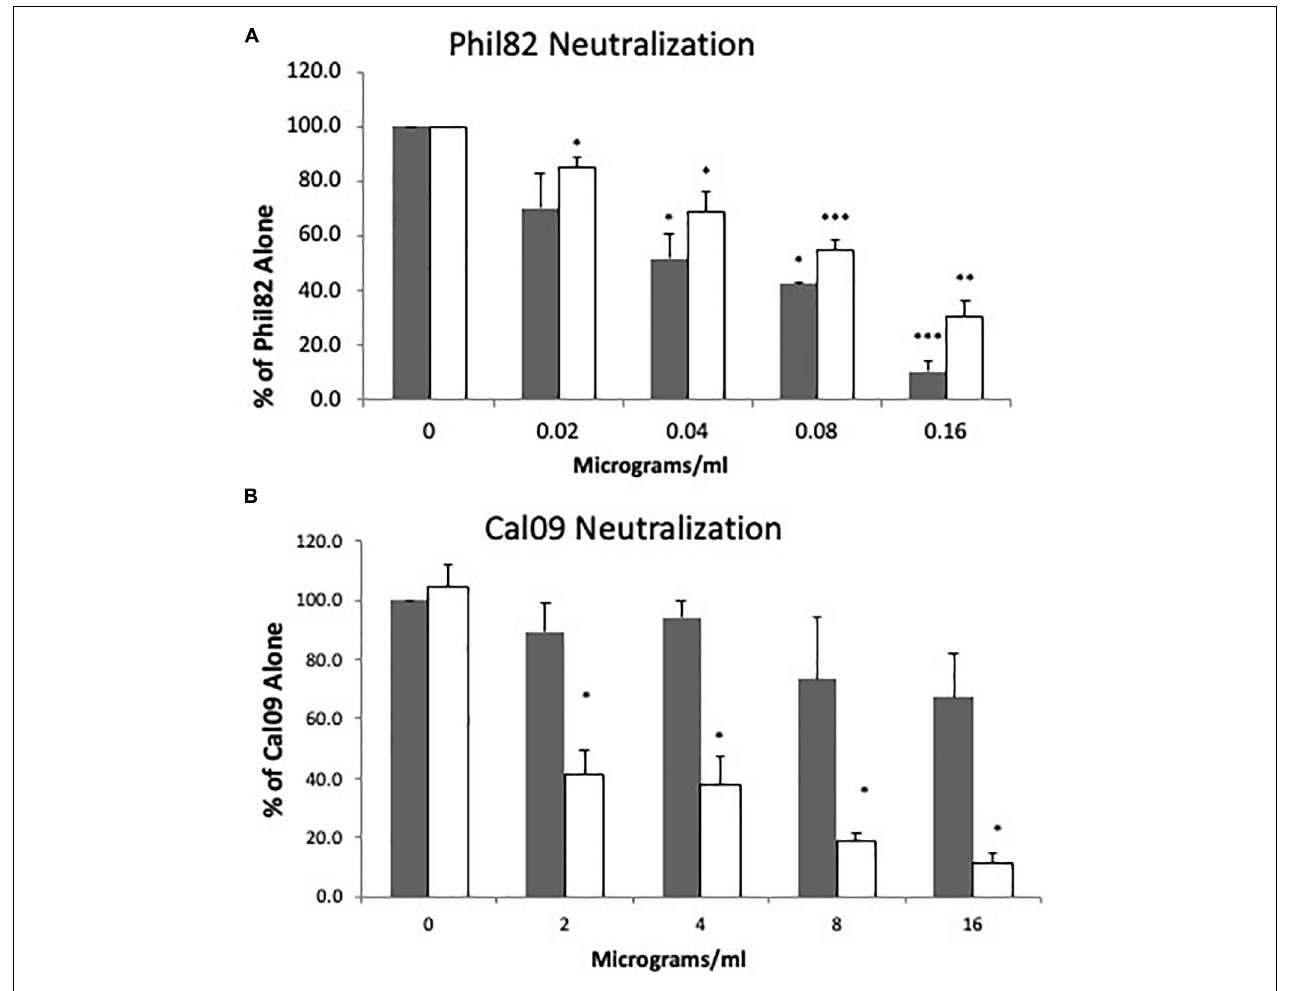
FIGURE 6 | Neutralizing activity of double mutant D325A + R343V vs. triple mutant D325A + F335A + R343V. We tested the neutralizing activity of the noted NCRDs against Phil82 (A) or Cal09 (B) . D325A + R343V is shown by black bars, and D325A + F335A + R343V is shown by white bars. Both NCRDs caused significant inhibition of the Phil82 strain in the ng/ml range ( ∗ p < 0.05, ∗∗ p < 0.01, and ∗∗∗ p < 0.005). In these experiments the triple mutant D325A + F335A + R343V caused significant inhibition of the Cal09 strain in µ g/ml range ( ∗ p < 0.05 vs. control; mean ± SEM; n =